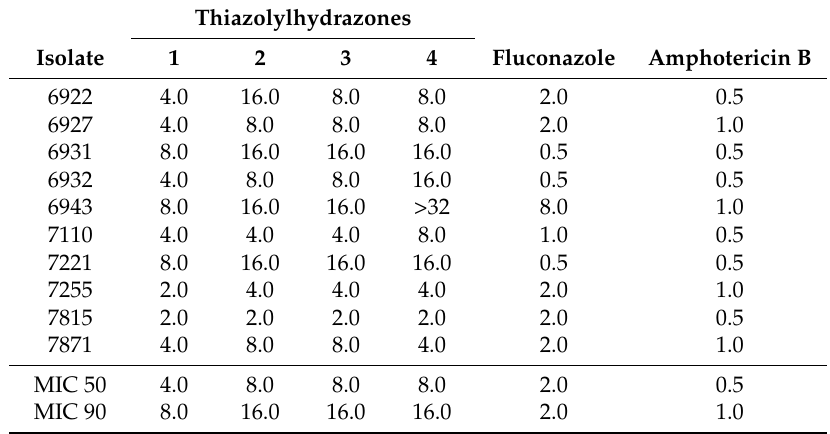
Table 4. MIC * of thiazolylhydrazones compounds against Candida glabrata clinical isolates.